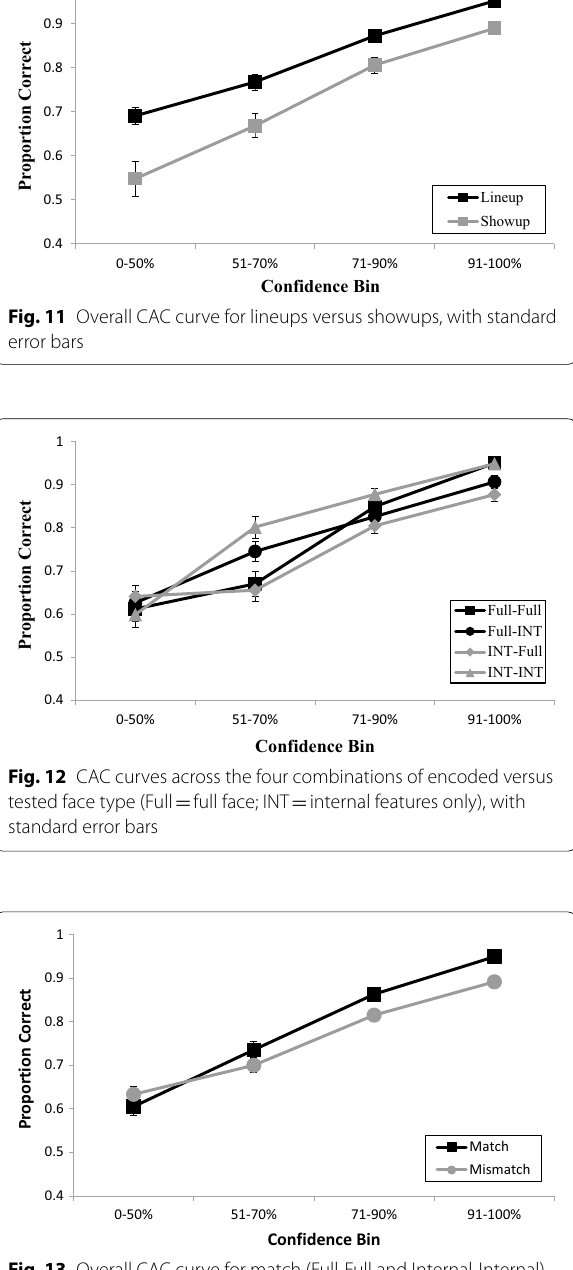
Fig. 13 Overall CAC curve for match (Full-Full and Internal-Internal) versus mismatch conditions (Full-Internal and Internal-Full), with standard error bars